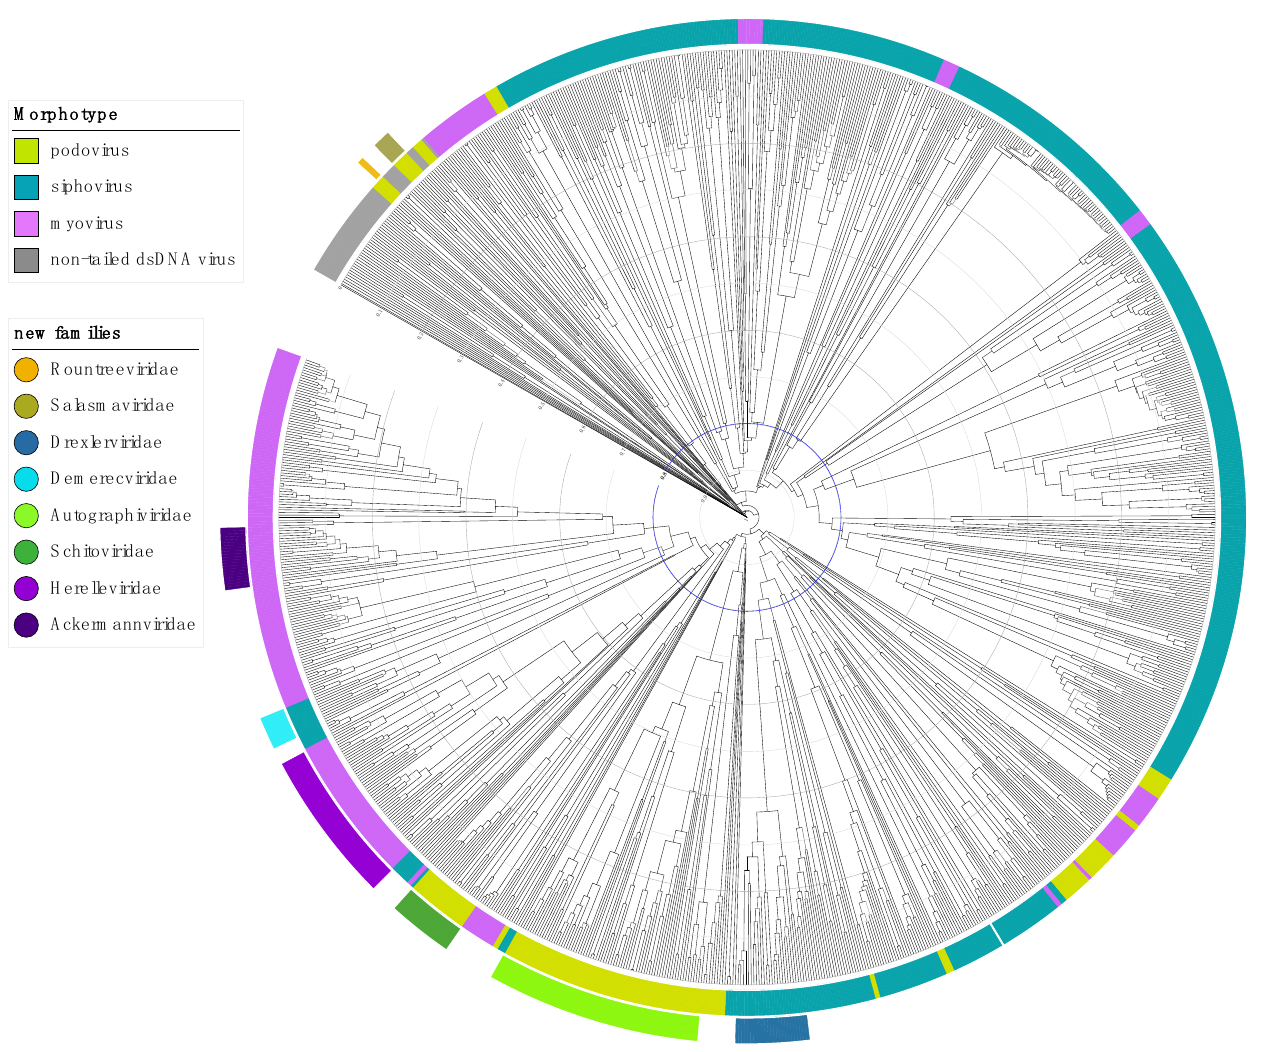
Figure 2. Dendrogram generated by GRAViTy (http://gravity.cvr.gla.ac.uk, accessed on 5 February 2021) for DB-B: Baltimore Group Ib—Prokaryotic and archaeal dsDNA viruses (VMRv34) and annotated using iTOL [16,42]. The inside coloured ring indicates the morphotype and the outside ring the new proposed and ratified families as of 2021. The distance from tip to node, indicated by the scale rings, represents the composite generalised Jaccard distance (0–1) between two genomes calculated based on relatedness of the proteins and the genome organisation, where 0 is identical and 1 is no measurable relation between two genomes. The Jaccard distance of 0.8, unifying the majority of eukaryotic virus families is indicated in blue for illustration purposes. Bootstrap values (0–1) are indicated by branch colour on a greyscale, from light grey (0) to black (1), showing that the majority of branches are well-supported. Bootstrap values were calculated as described by Aiewsakun and Simmonds [16] by random resampling of the protein profile hidden Markov models that form the basis of the protein relatedness score, recomputing the pairwise distance matrix and then recomputing the dendrogram and repeating this 100 times.